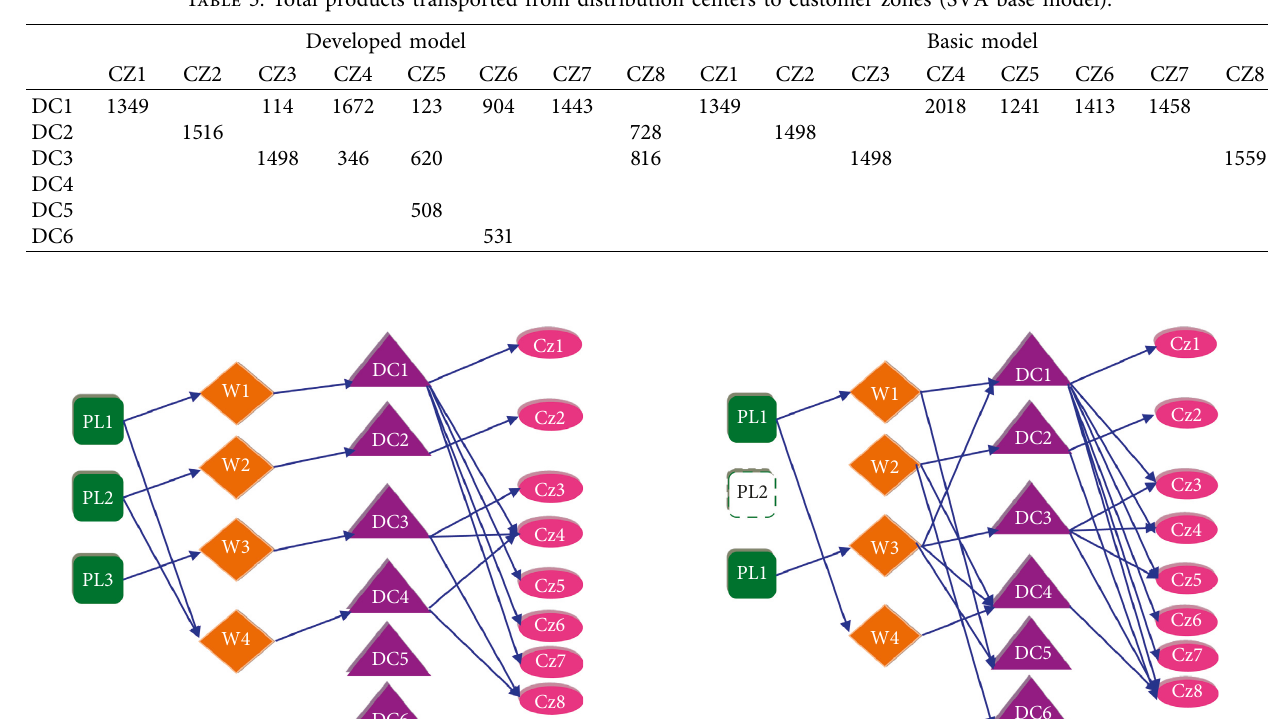
Table 5: Total products transported from distribution centers to customer zones (SVA base model).